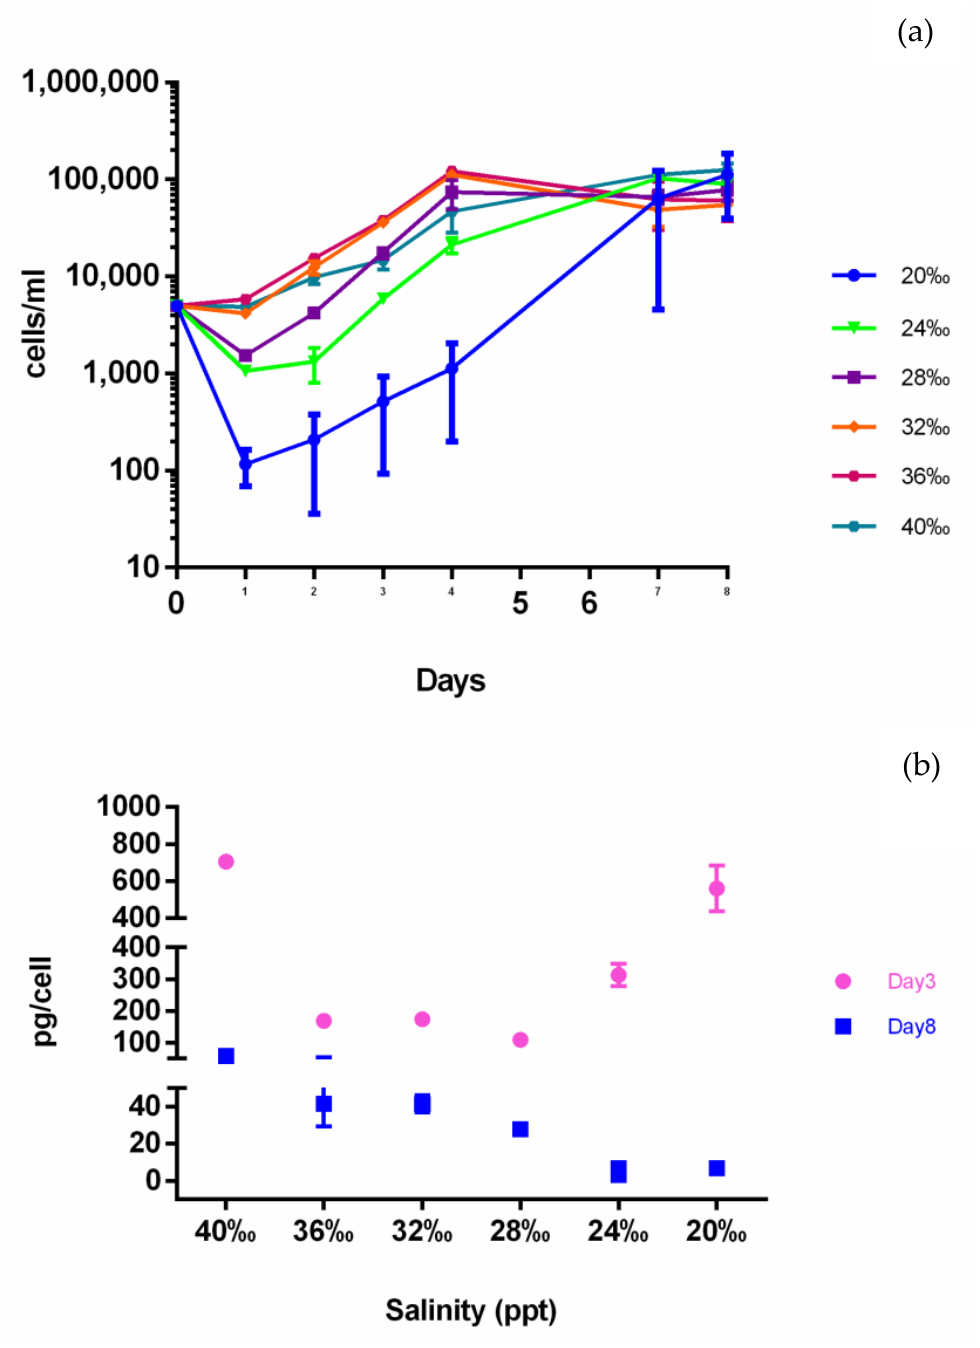
Figure 3. Ectoine quantification in xenic T. rotula culture. ( a ) Growth curves of T. rotula in media with different salinities; ( b ) ectoine amount, reported as pg per T. rotula cell. Day 3 = third day of growth; day 8 = eighth day of growth.